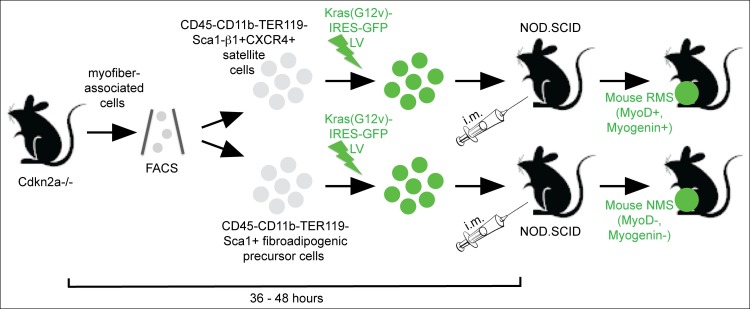
Sarcoma induction strategy.Muscle satellite cells and fibroadipogenic precursor cells were isolated by FACS according to the indicated cell surface markers from mouse skeletal muscle freshly dissected from Cdkn2a-/-(p16p19null) mice. Freshly sorted cells were transduced with oncogenic Kras using a Kras (G12v)-IRES-GFP lentivirus, and transduced cells were implanted into the cardiotoxin pre-injured extremity muscles of NOD. SCID mice by intramuscular (i.m.) injection within 36–48 h from cell isolation. The myogenic differentiation status of the resulting Ras-driven sarcomas generated in this system was largely dependent on the cell type transduced: satellite cells typically gave rise to rhabdomyosarcoma (RMS; MyoD +, Myogenin + ), whereas the identical oncogenetic lesions introduced into fibroadipogenic precursors within the MFA cell pool almost always produced sarcomas lacking myogenic differentiation features (MyoD-, Myogenin-; non-myogenic sarcomas, NMS) (Hettmer et al., 2011).